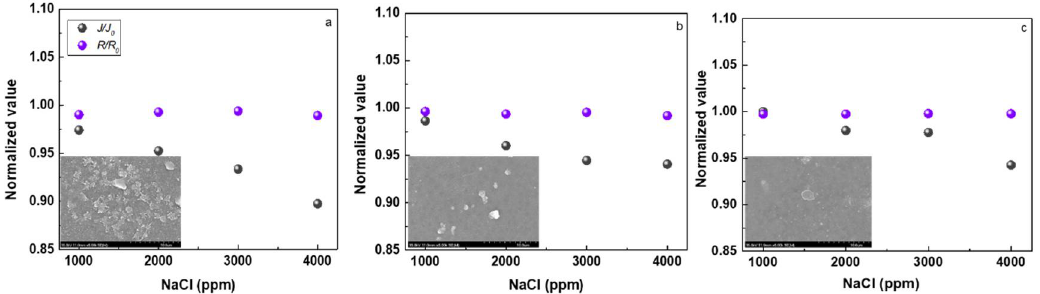
Figure 9. The normalized reverse osmosis performance of the fouled membrane with different salt concentration. ( a ) PAUt membranes; ( b ) PAUt-CS membranes and ( c ) PAUt-PDDA/PSS/CS membranes. Testing conditions: Applied pressure is 1.55 MPa with 1000–4000 ppm NaCl as feed solution at 25.0 ± 2.0 °C.